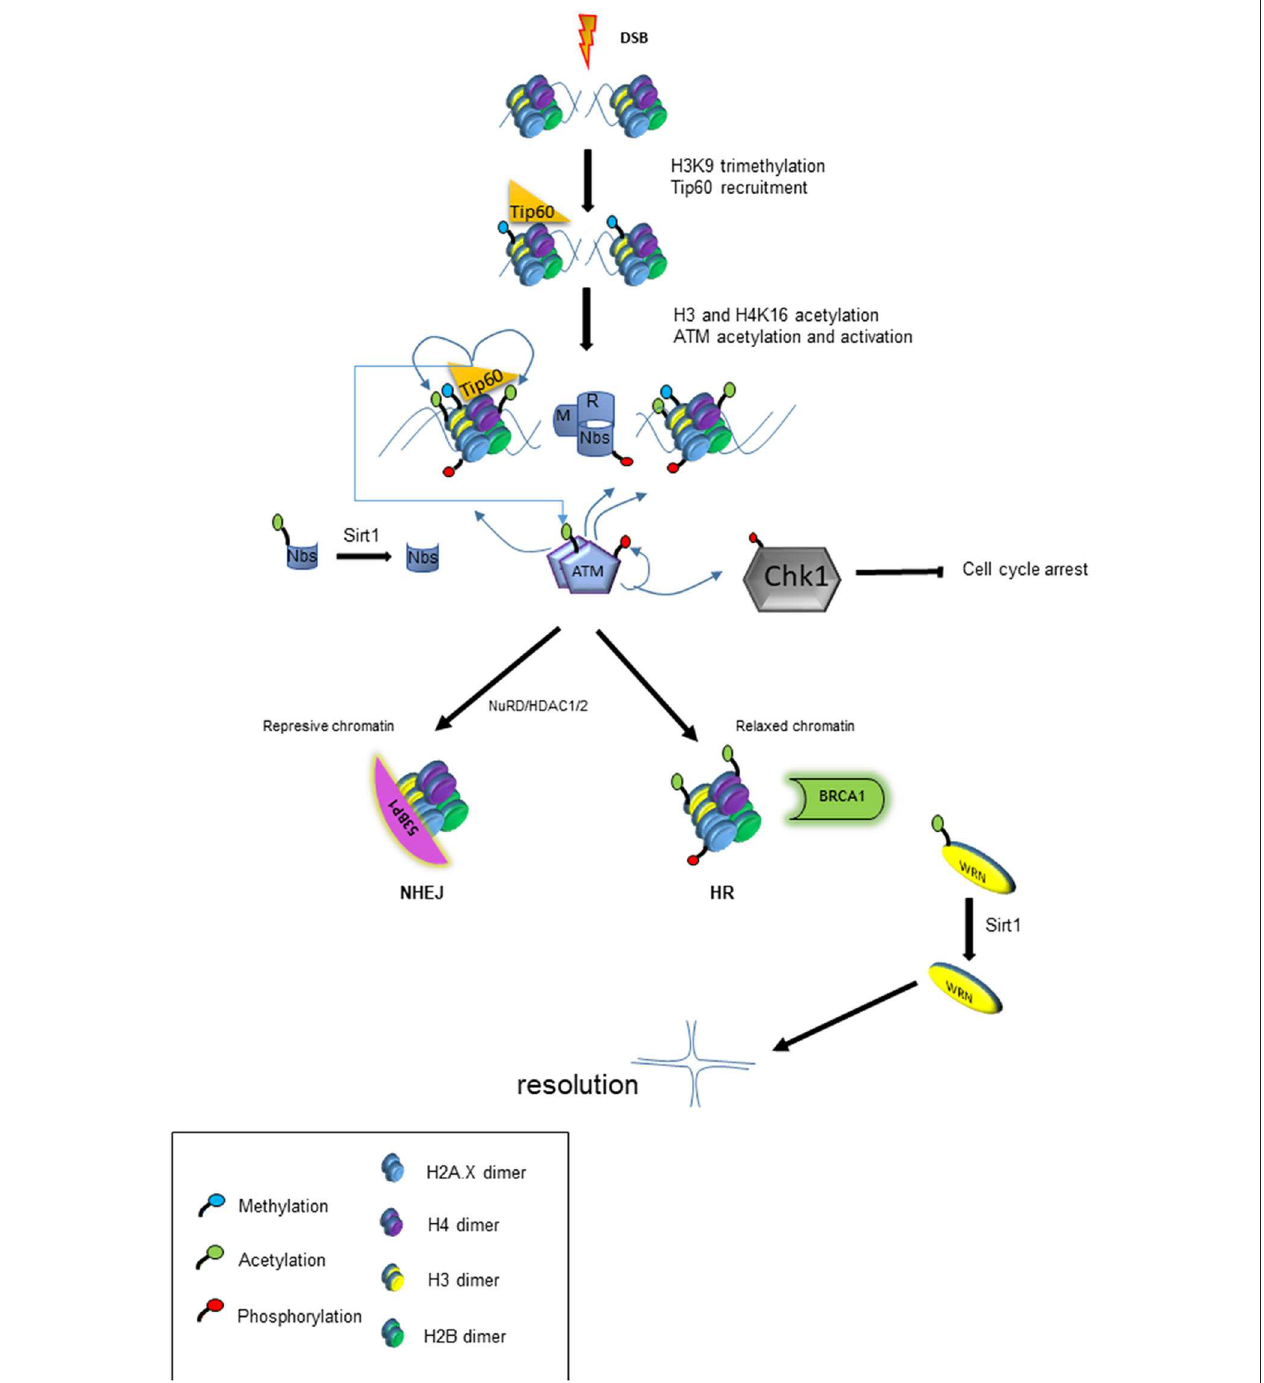
FIGURE 3 | Model of chromatin modification and its impact on DDR. The panel shows the cascade of events that lead to chromatin modification and other post-translational modifications (PTM) that trigger HRR or NHEJ response.